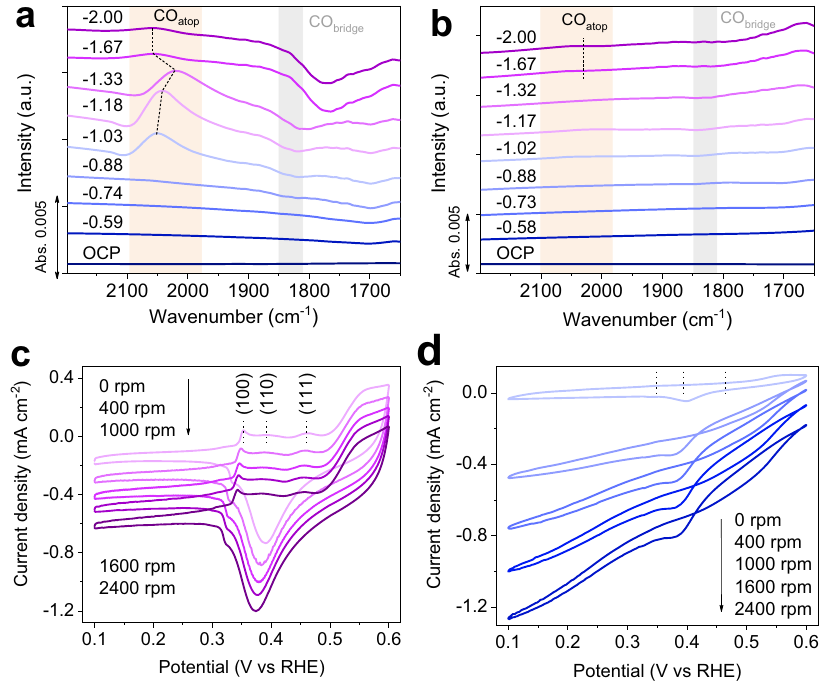
Fig. 4 | In situ experimental evidence for microenvironment modulation. a , b ECSA-normalized in situ ATR-SEIRAS spectra of acidic CO 2 RR collected on ER- CuNS ( a ) and F-CuNS ( b ) catalysts under different applied potentials (V RHE ) in